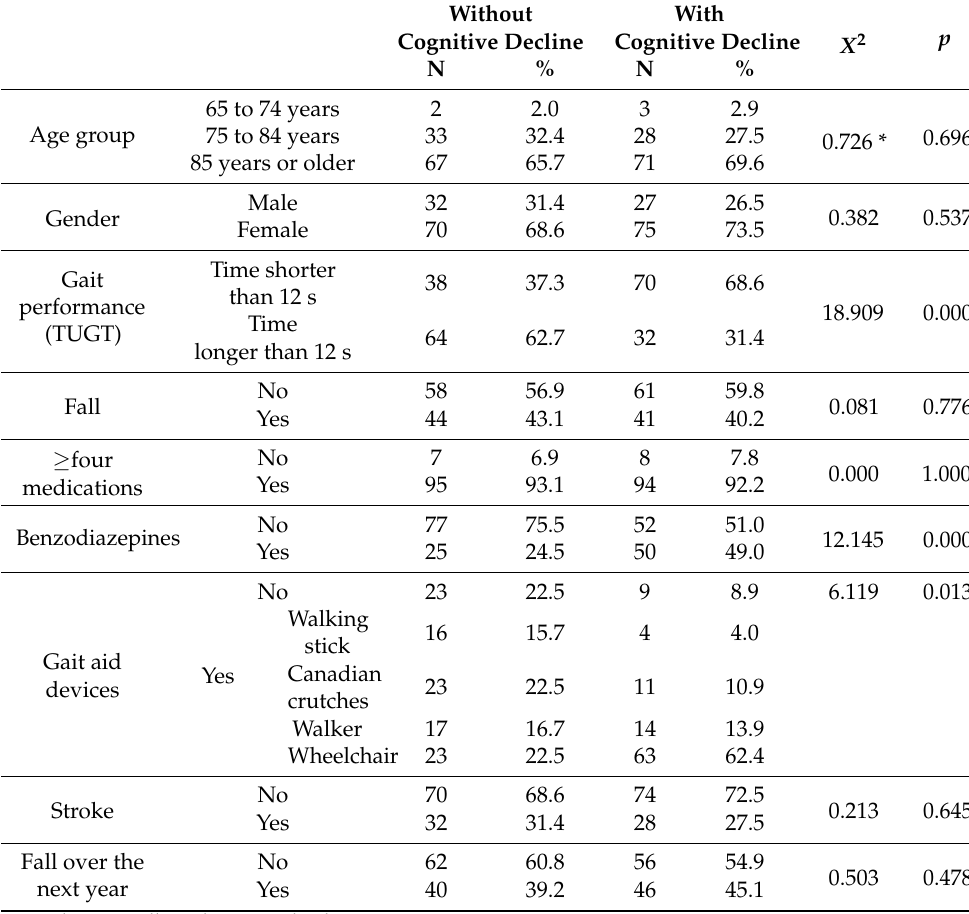
Table 1. Sociodemographic and clinical characteristics of older persons by cognitive state.